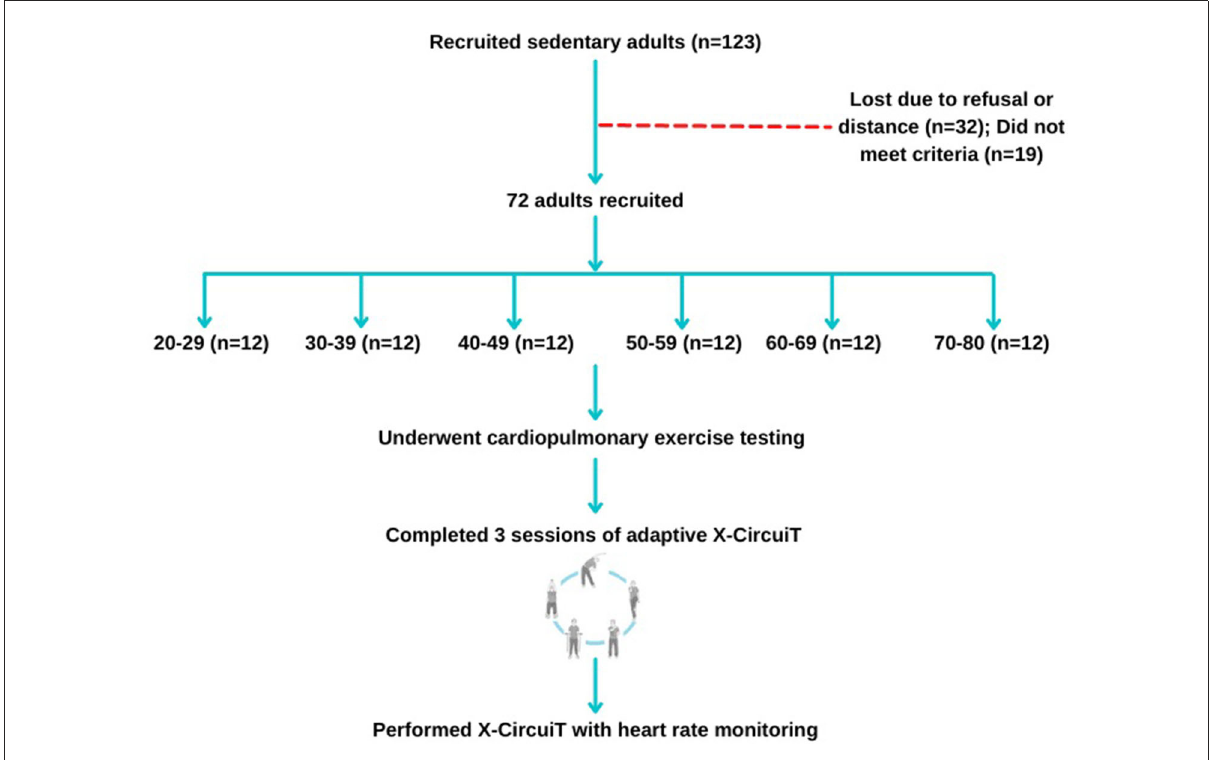
FIGURE1 Participant recruitment, randomization, and study